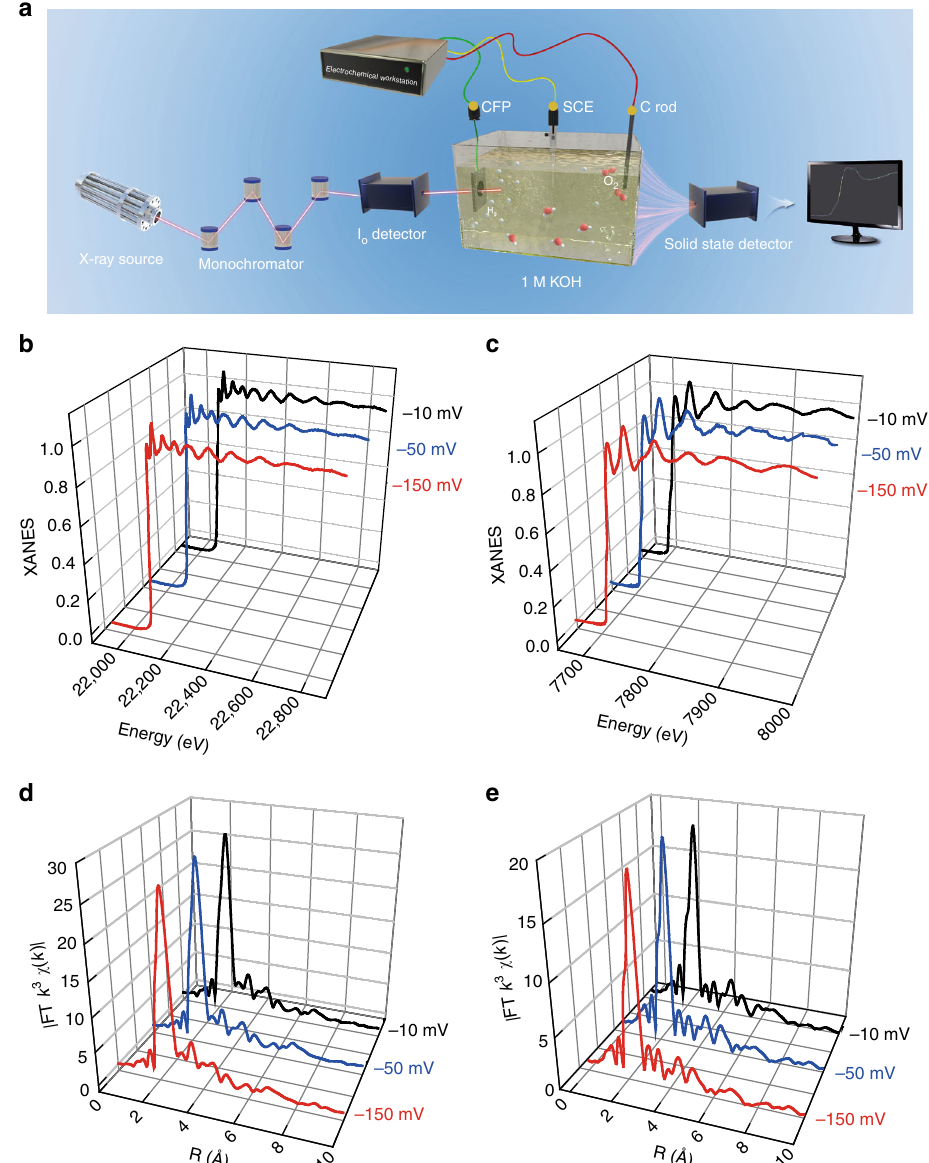
Fig. 4 In situ XAFS measurements for Co-substituted Ru catalyst. a Schematic illustration of in situ XAS measurements for Co-substituted Ru. CFP and SCE represent carbon fi ber paper and saturated calomel electrode, respectively. XANES spectra of Co-substituted Ru for the b Ru K-edge and c Co K-edge at different voltages. EXAFS spectra for the d Ru K-edge and e Co K-edge at different